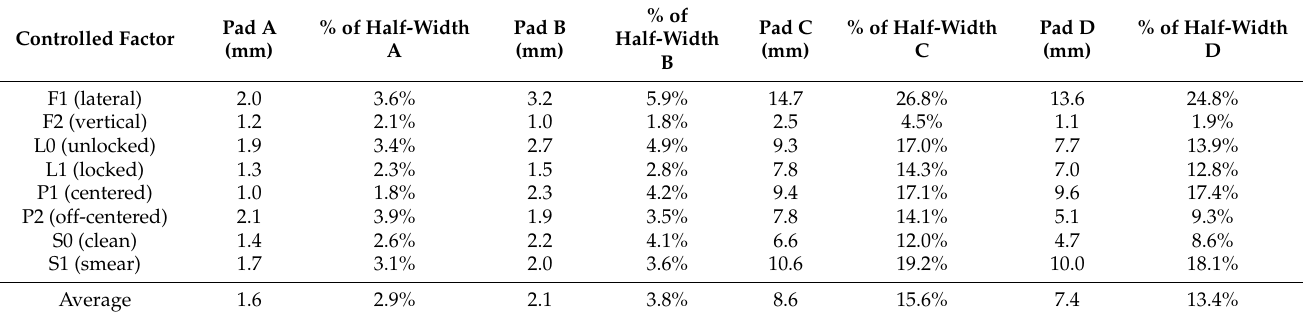
Table 7. Foldable steel support pad (Pa2)—Mean support pad slippage for different controlled factors.